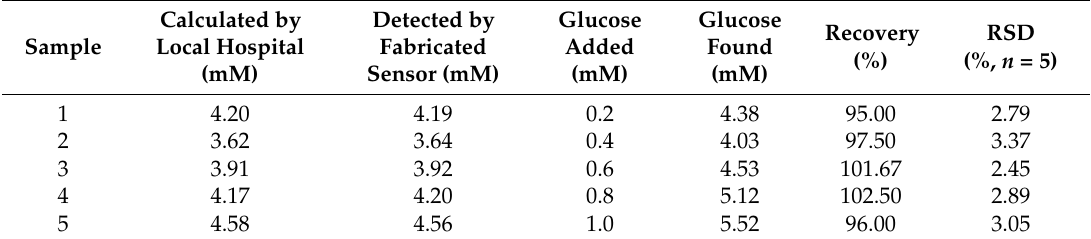
Table 2. Determination of glucose in real human serum sample with fabricated sensor.